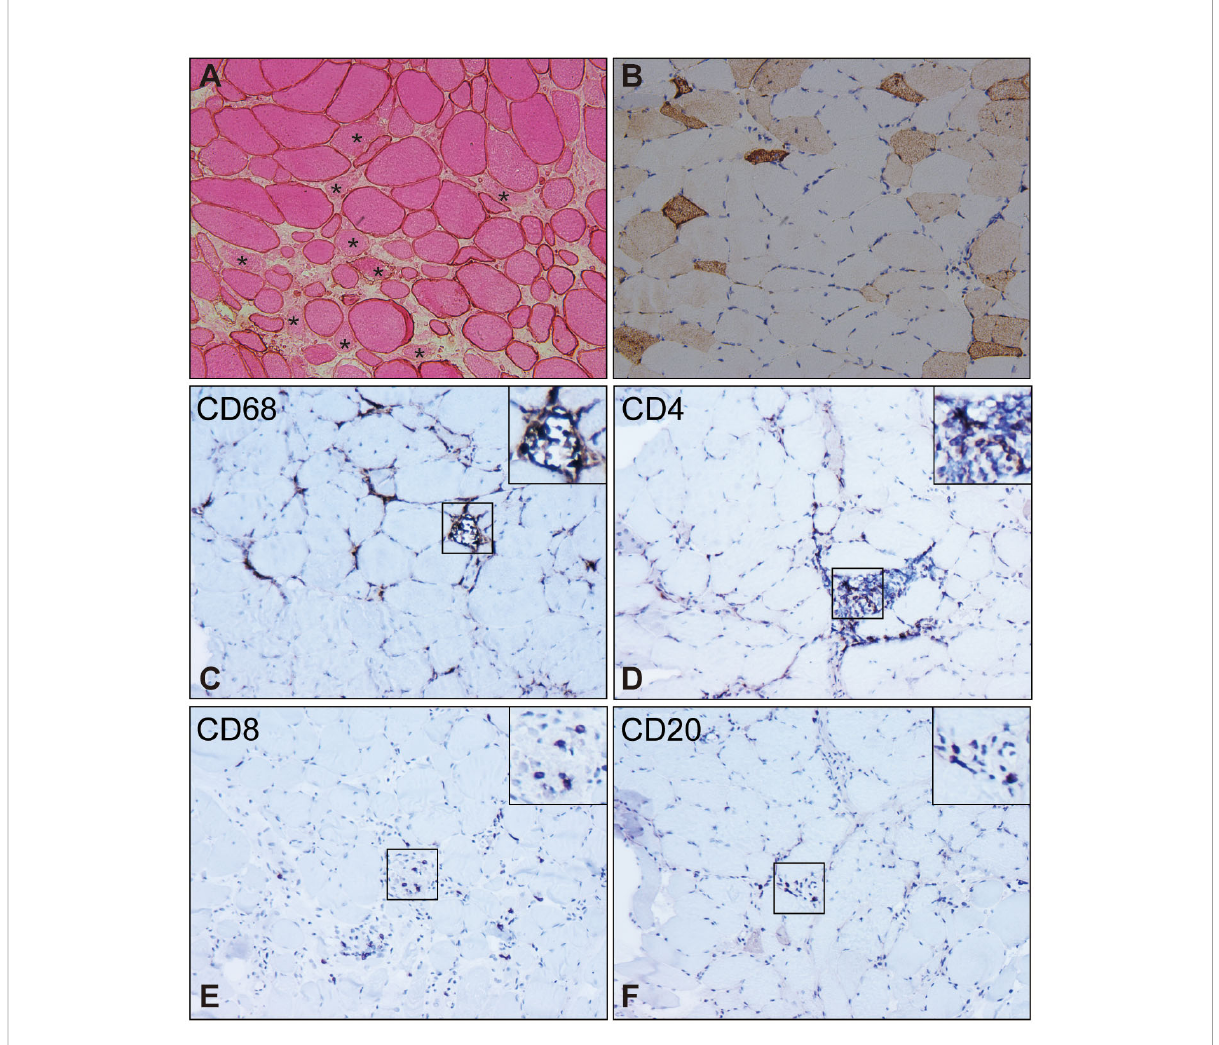
FIGURE 2 Pathological characteristics of muscle biopsy in SRP-IMNM. (A) , dystrophin combined with eosin staining reveals necrosis myo fi bers (asterisk). (B) , immunohistochemical staining of Neural Cell Adhesion Molecule1 (NCAM1)/CD56 shows scattered myo fi ber regeneration. In fl ammatory cell analysis demonstrates scattered or focal CD68 + macrophage in fi ltration and myophagocytosis (C) , scattered CD4 + (D) and CD8 + T lymphocyte (E) , and a few CD20 + B lymphocytes (F) . Magni fi cation (A-F) : 200x. These pictures are cited from our previous study (7,